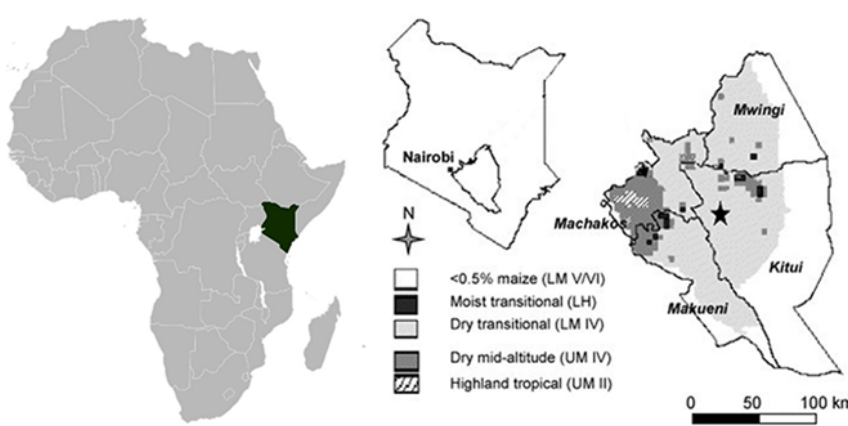
Figure 1. Study area. Dry transitional maize agro-ecological zone (right) located in south-eastern Kenya (centre) in the Horn of Africa (left). The area where the survey data (Wens et al., 2021) are collected is indicated with a star on the right map. Map adjusted from Barron and Okwach